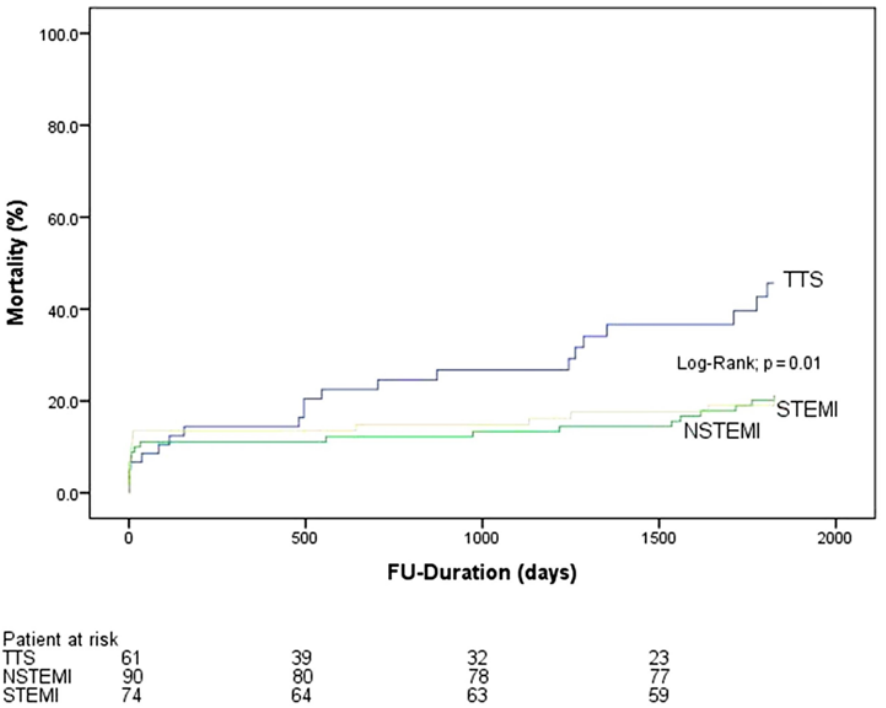
Figure 3. Mortality rate in patients suffering from takotsubo cardiomyopathy (TTS) and KF compared to patients with NTEMI, STEMI, and kidney failure at five-year follow-up.